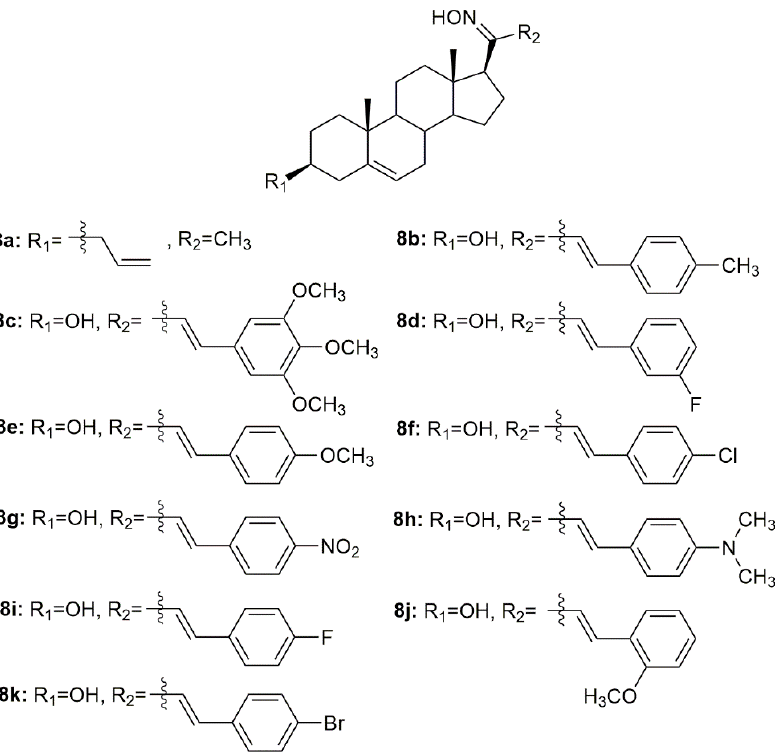
Figure 11. Pregnane oxime derivatives with antimicrobial activity. Table 10. MIC values of (µg/mL) of the synthesized pregnane oxime derivatives. Adapted with permission from Ref [88], 2023, Ana S. Pires.